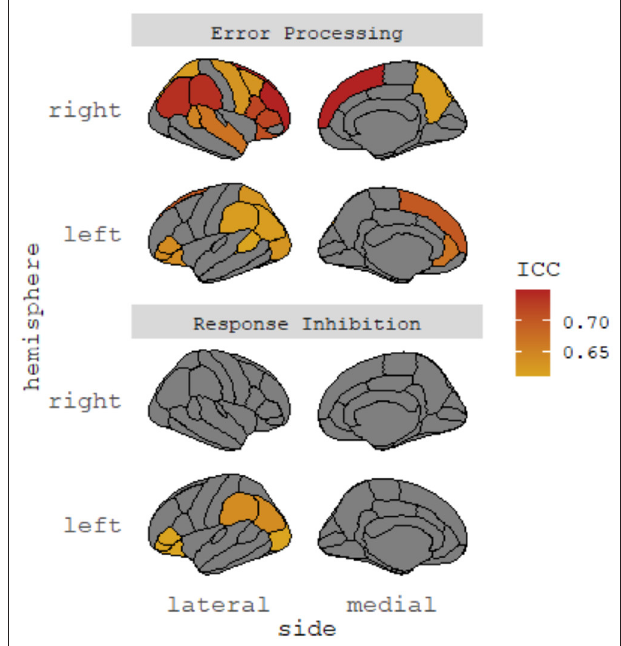
FIGURE 1 | Selected brain regions with high test-retest reliability. ICC, intraclass correlation coefficient. The identified cortical regions showed significant test-retest reliability (ICCs > 0.60) in Korucuoglu et al. ( 45). No subcortical regions showed significant test-retest reliability in the study. Brain regions identified were cross-checked with Hagler et al. (